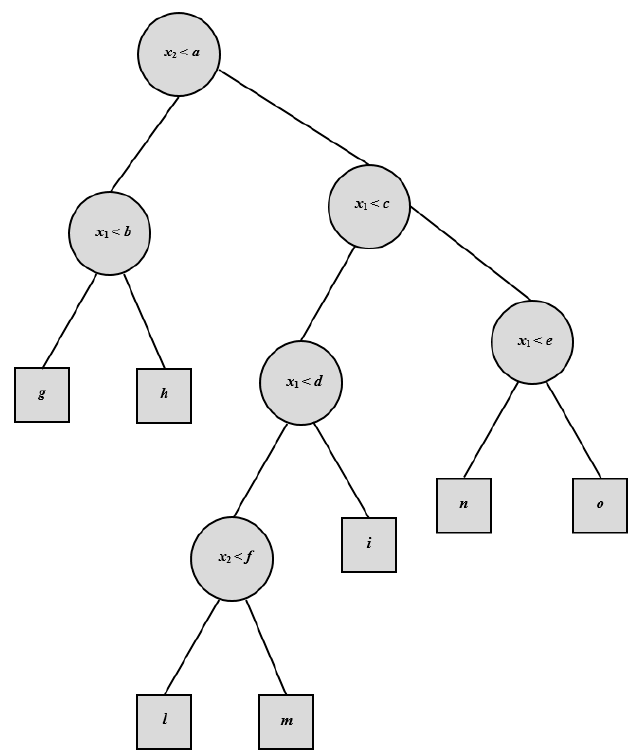
Figure 2. A typical Regression Tree architecture.